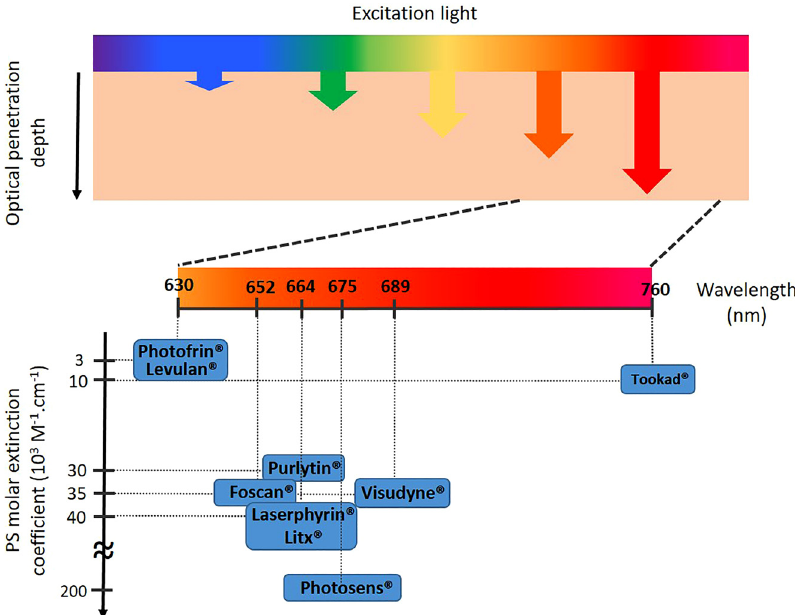
Figure 2: Above: representation of the optical penetration depth of the electromagnetic light spectrum across biological tissues. Below: main clinically approved PSs at their wavelength of therapeutic